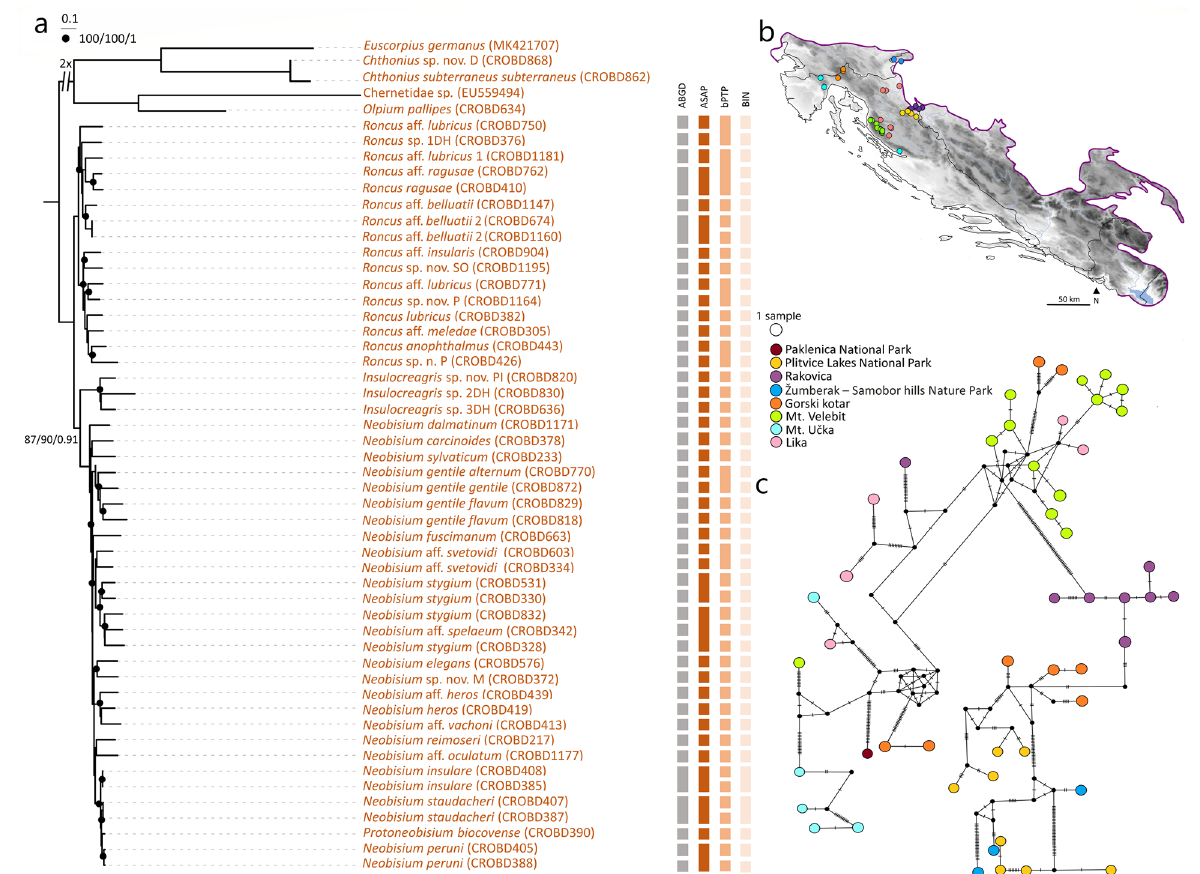
Figure 6. ML phylogram of the concatenated COI-28S Neobisiidae subset with species delineation results, and median-joining haplotype network for Neobisium stygium . ( a ) Node support is reported as ultrafast bootstrap resampling frequencies (BS), followed by the Shimodaira-Hasegawa-like (SHL) approximate likelihood ratio and posterior probabilities (PP). Branches with ultrafast bootstrap support value (100), SHL approximate likelihood ratio (100) and posterior probabilities (1) were marked with black dots. Morphospecies were mapped onto the terminals of the ML along with the Sample IDs as in Supplementary Table 1 online. Colour strips refer to species delimitation results (MOTUs) as indicated by ABGD, ASAP, bPTP, and BIN assignments. ( b ) Sampling localities (colour coding matches insert in Fig. 6c). Map was made using Cartopy package ver. 0.19 (https:// scito ols. org. uk/ carto py/ docs/ v0. 18/ index. html) in Python ver. 3.8. ( c ) Median-joining haplotype network for Neobisium stygium based on the COI gene. Haplotype circles are colour-coded according to localities and circle size is proportional to overall haplotype frequency. Black dots indicate the extinct ancestral or unsampled haplotypes. Numbers of mutational steps are given as hatch ASAP-score 11.50) inferred 130 putative species and agreed most with morphological identifications. The bPTP method inferred the highest with 199 putative species. Using the BOLD’s BINs, sequences were allocated to 236 BINs represented single individuals (singletons) and there is clearly a need for examining additional specimens to estimate true BIN diversity within the Chthoniidae and Neobisiidae. ABGD, bPTP and BIN assignments altogether split the species Neobisium stygium , Roncus lubricus and Chthonius magnificus Beier, 1938, mostly according to collection sites. For detailed results of applied species delineation methods, see Supplementary Table 1 and Supplementary Table 5 online. For COI sequence clustering within the concatenated Chthoniidae subset (29 morphospecies), the ABGD method delineated 32 putative species that were mostly congruent with morphological identifications (Fig. 5c). ASAP, with the best ASAP-score (1.50), indicated 38 putative species, bPTP recovered 34 putative species, and the BOLD’s assignment resulted in 39 BINs. For the concatenated Neobisiidae subset (39 morphospecies), ABGD delimited 44 putative species, ASAP, with the best ASAP-score (3.50) predicted 40 putative species, bPTP resulted in 41 species, and the BOLD assignment revealed 45 BINs (Fig. 6a). Overall, for all datasets, ABGD and ASAP provided conservative estimates of putative species, while bPTP and BIN assignments indicated potential over- splitting when compared with morphology.